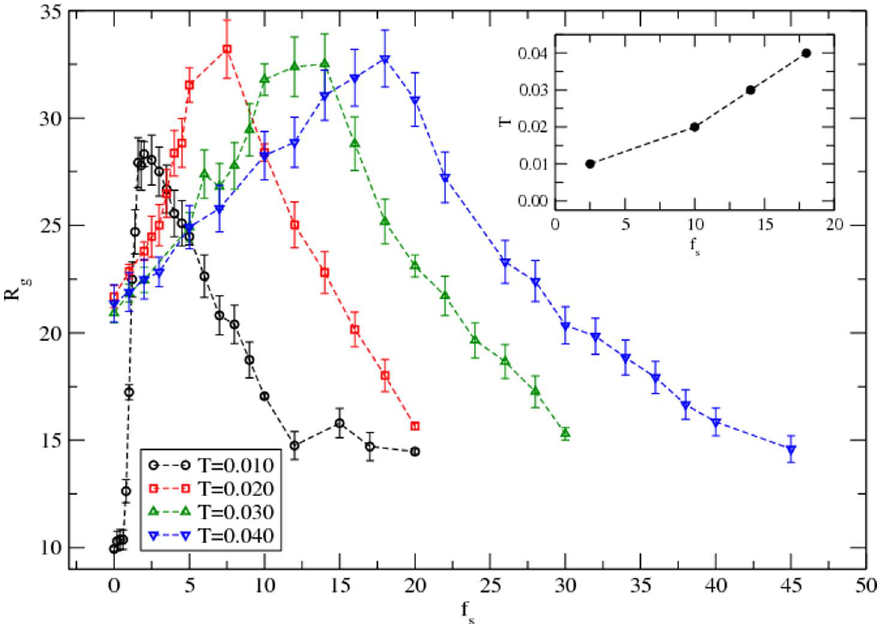
Figure 5. Variation of the radius of gyration of the protein with the magnitude of the solvent interaction at temperatures T=0.010– 0.040 . Simulations are performed on a 64 3 lattice with 100 independent samples at each temperature and solvent strength.